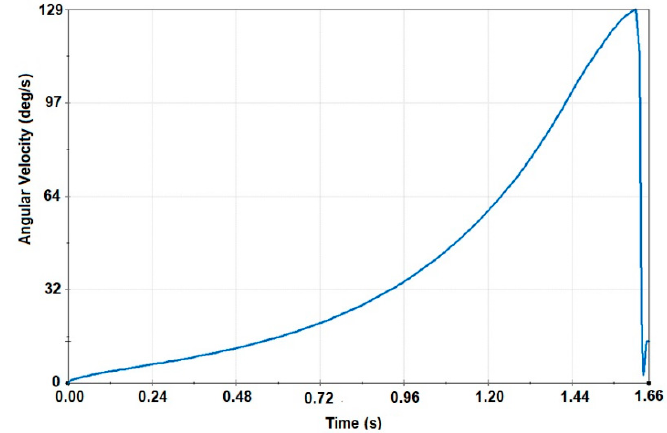
Figure 5. The position of the frame rollover when the frame is loaded with an additional mass of 610 kg.